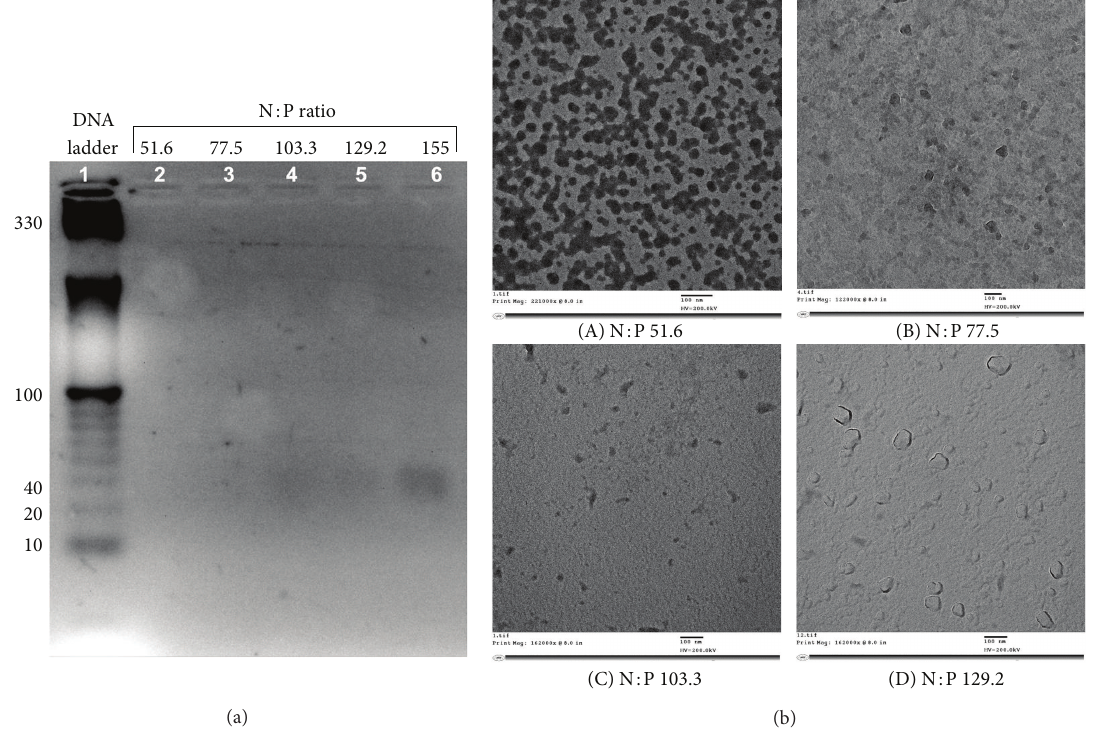
Figure 2: (a) Gel retardation assay was performed to evaluate maximum gene (siRNA) loading efficiency in the nanoparticles. Lane 1 represents a 10bp DNA ladder used as a reference. Lanes 2, 3, 4, 5, and 6 represent various N :P ratios tested. The N:P ratio of 129.2 showed optimal siRNA loading with CS-PEG-CP15 polymer solution. (b): TEM image of CS-PEG-CP15/siRNA nanoparticles complexing siRNA at various N :P ratios: (A) 51.6 (mag. 221000x), (B) 77.5 (mag. 122000x), (C) 103.3 (mag. 162000x), and (D) 129.2 (mag.